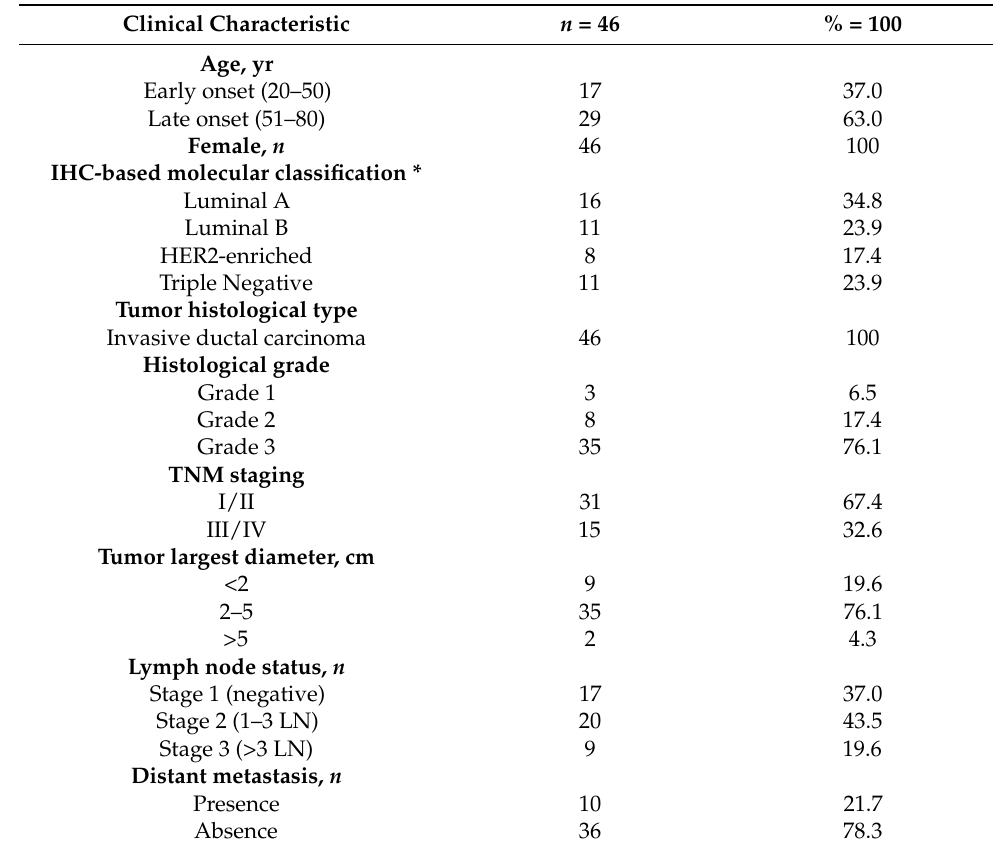
Table 2. Clinicopathological characteristics of